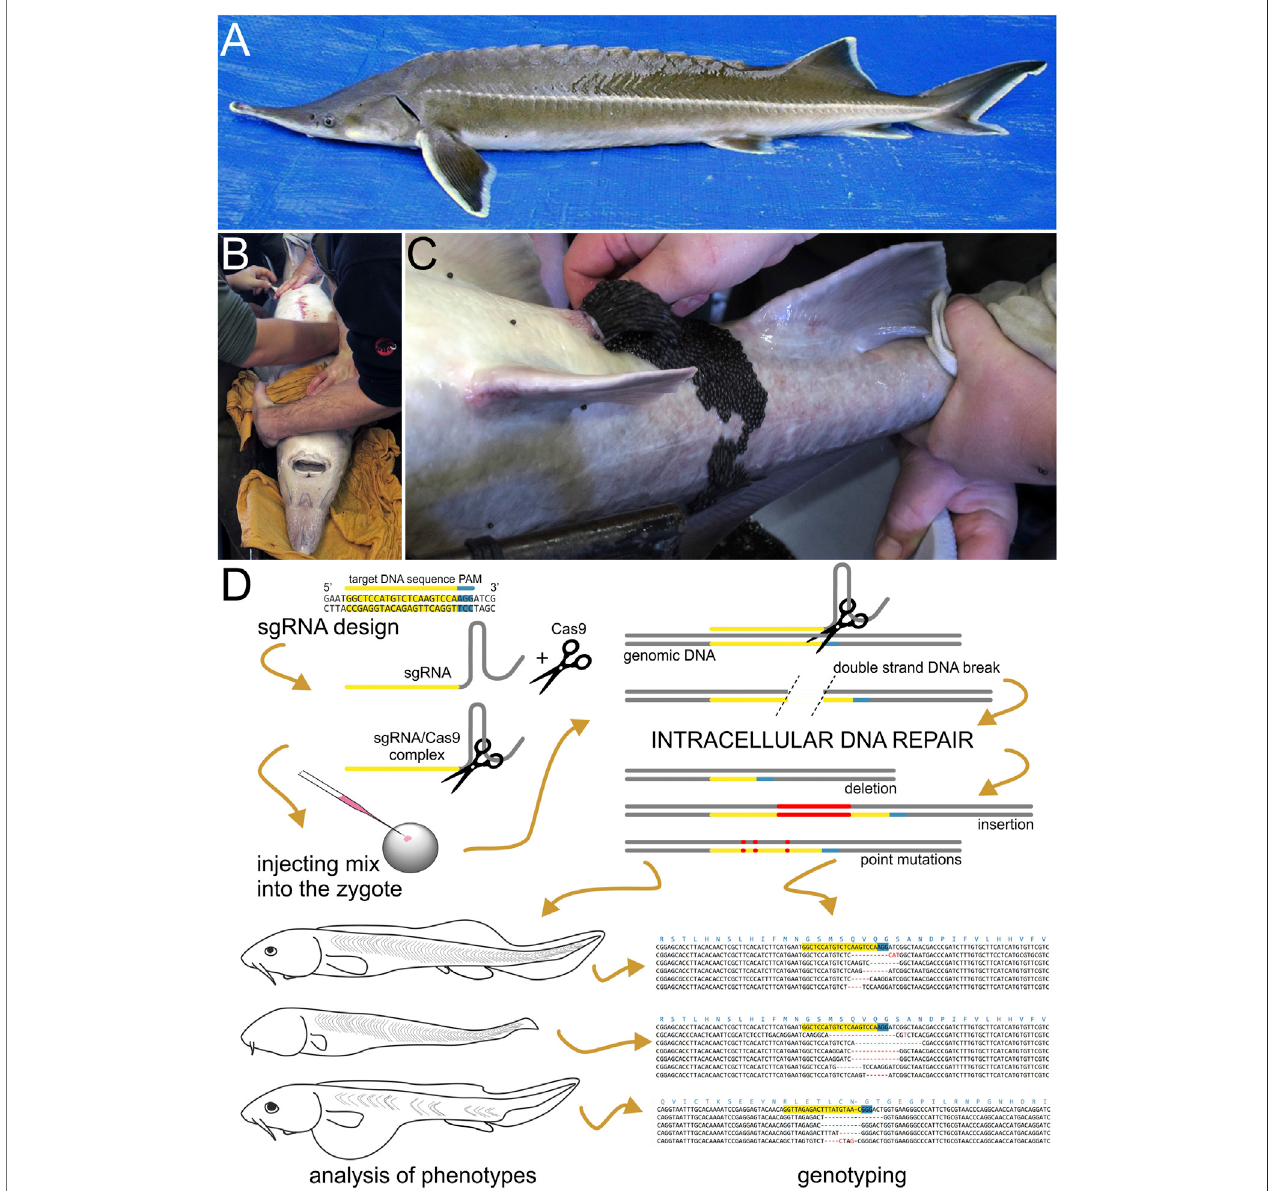
FIGURE 1 | Sturgeon and CRISPR/Cas9 mutagenesis pipeline. (A) Dorsoleteral view of an adult individual of sterlet ( Acipenser ruthenus ). Abdomen of an adult anesthetized sturgeon female (pictured here is the Siberian sturgeon, Acipenser baerii ) in dorsal recumbency (B) is manually massaged in anterior-to-posterior direction andovulatedeggsarecollectedintoabowl (C) . (D) AschemeillustratingthesterletCRISPR/Cas9mutagenesispipeline.First,thesingleguideRNA(sgRNA)isdesigned andsynthesizedbasedontheselectedtargetDNAsequencesandnexttoProtospacerAdjacentMotif(PAM).PAMisrequiredforproperfunctionofCas9nuclease and is not part of sgRNA. Next, the sgRNA is mixed with Cas9 protein (illustrated here as scissors) to form a sgRNA/Cas9 complex. This mix is injected into sterlet zygotes.Cas9nucleasenavigatedtothetargetbysgRNAbreaksthedoublestrandofDNA,whichissubsequentlyrepairedinsidethecleavingcellsandnuclei.(mainlyby non-homologous end joining) The imperfect DNA repairs introduce mutations into newly synthesized molecules ofDNA resulting into amosaic ofcells bearing DNA with indels and/or point mutations at the targeted site. Embryos and/or raised larvae are later inspected for phenotypic effects and selected candidates are genotyped.